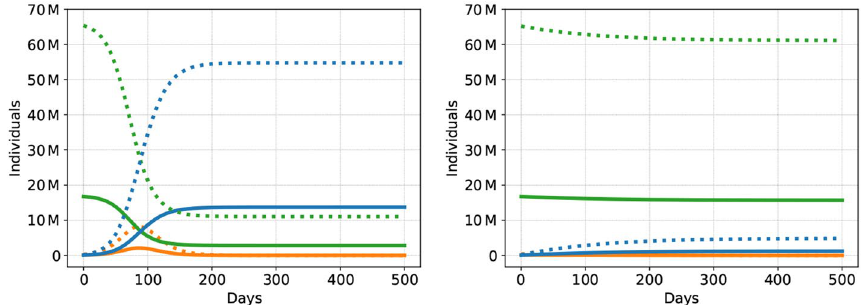
Figure 1. Dynamics of the COVID-19 epidemic for the B2 (left) and the USD2 (right) scenario: susceptible individuals in green, recovered in blue, and aggregated asymptomatic, symptomatic, and severely infectious cases in orange. The group with low vulnerability has dotted curves, the group with high vulnerability is plotted solidly.